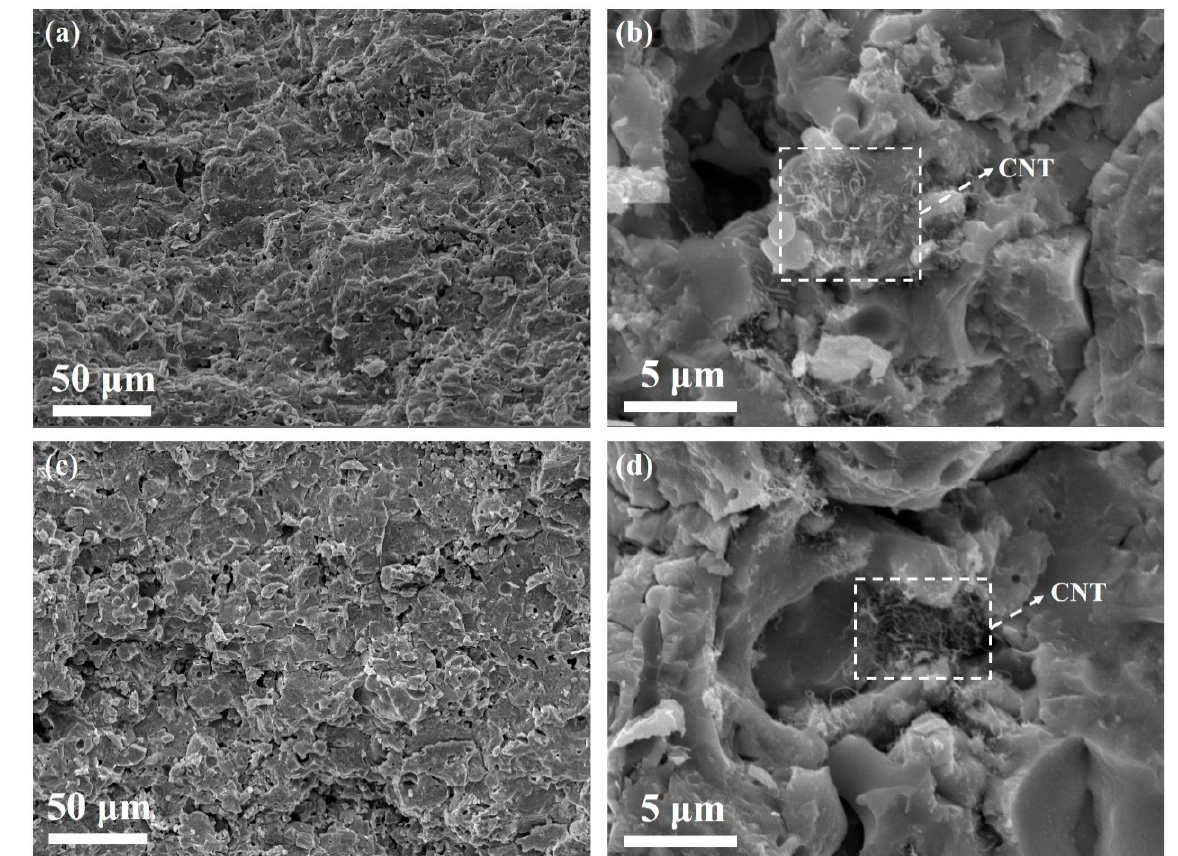
Figure 2. SEM images of Y 2 O 3 /ZrB 2 /CNT ceramics with ( a , b ) 83% Y 2 O 3 particles (Y83 sample) and ( c , d ) 81% Y 2 O 3 particles (Y81 sample).